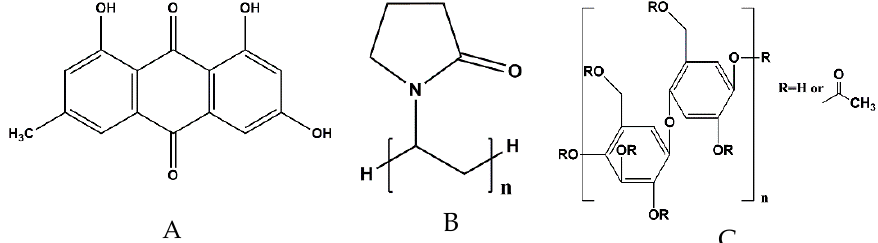
Figure 1. Structures of emodin and other excipients. ( A ) Emodin, ( B ) poly(vinyl pyrrolidone), ( C ) cellulose acetate.